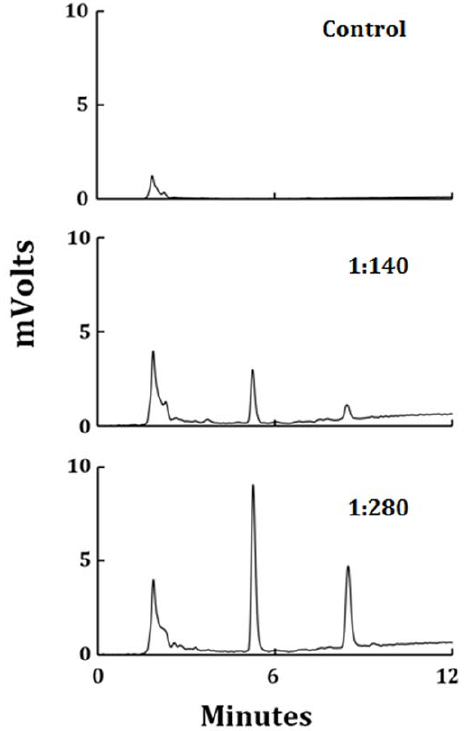
Figure 8. Treatment of LPO with HOCl leads to the generation of fluorescent heme degradation products. LPO (1.5 m M) was treated with increasing ratios of HOCl (control, 1:140. and 1:280) and analyzed by HPLC, as detailed in the Materials and Methods section. The fluorescent detector was set at excitation 321 nm and emission 465 nm. The molar ratio of the LPO:HOCl used for treatment is mentioned in inset of each panel. This data are representative of three independent